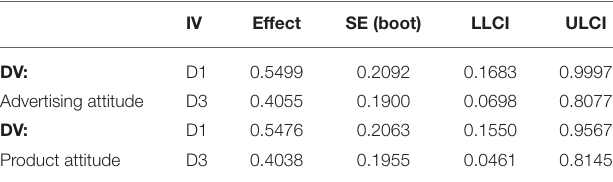
TABLE 1 | The mediation effect of mental imagery in Experiment